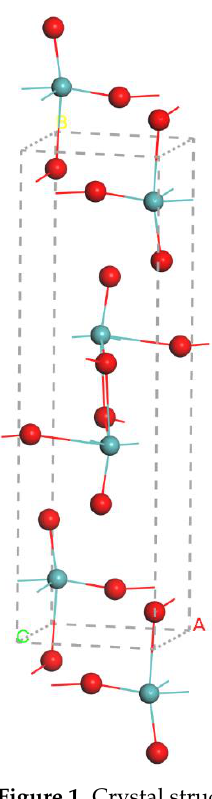
Figure 1. Crystal structure of MoO 3 .